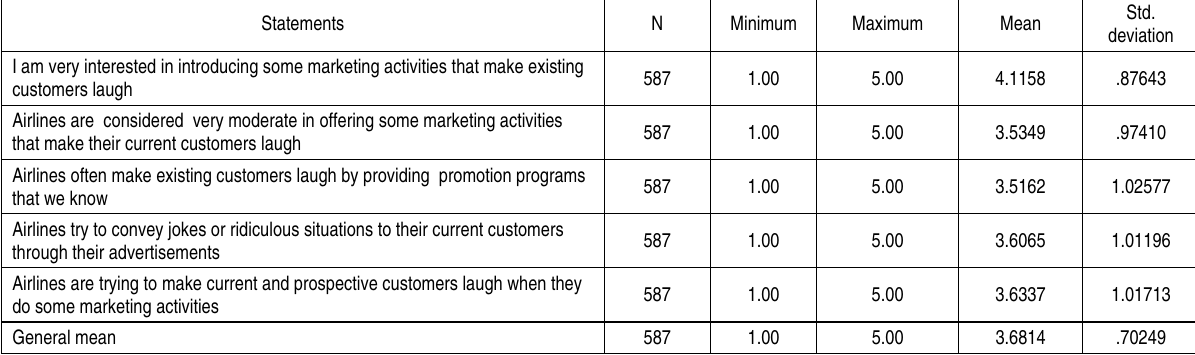
Table 5. Means and standard deviations of sample’s responses regarding the affiliated humor